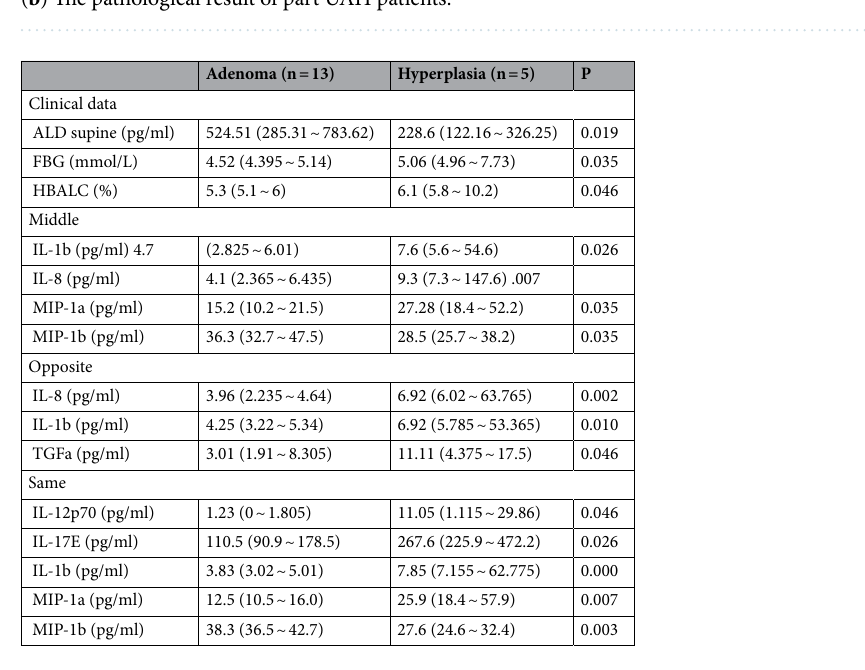
Table 4. Comparison of baseline data and cytokine levels between adenoma and hyperplasia groups. ALD supine: plasma aldosterone supine; FBG: fasting glucose; HBALC: glycosylated hemoglobin; Middle: Middle group; Opposite: Opposite group; Same: Same group. P < 0.05 are considered significant.